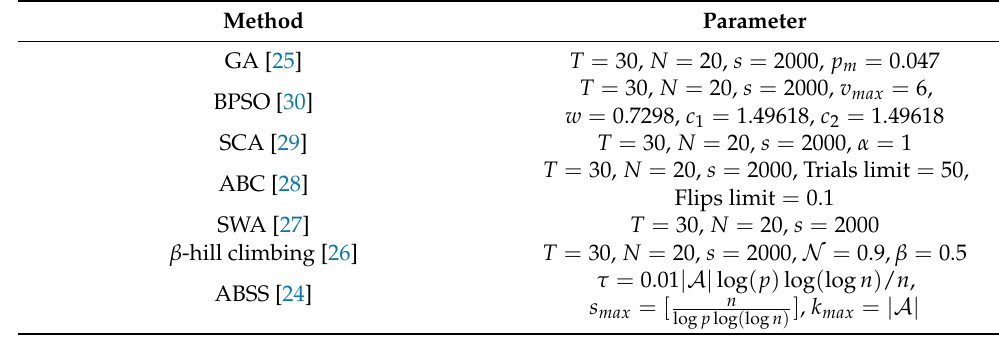
Table A1. The parameters settings of other feature selection methods in analyzing the body